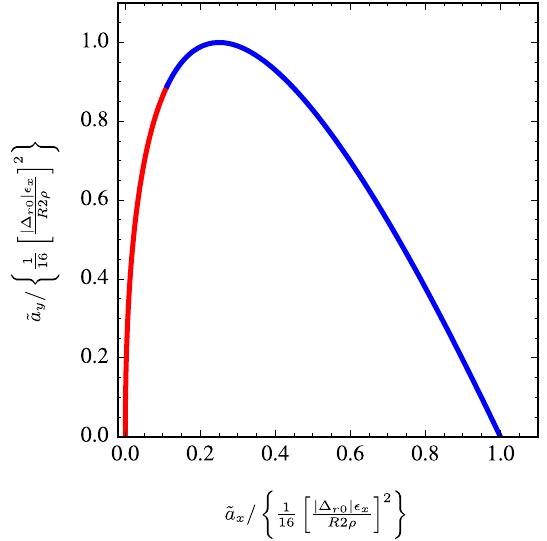
FIG. 2. Collection of all stationary points for the third-order normal resonance. In red are the stable and in blue the unstable solutions. In this picture for convenience we set ρ ¼ ρ n